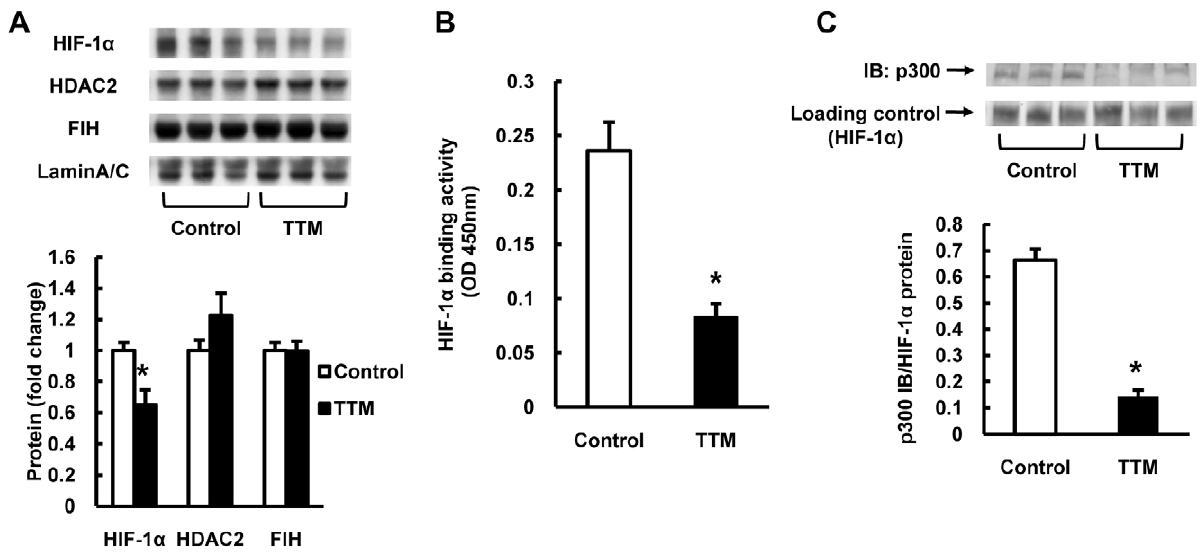
Figure 4. Copper depletion affects lung tissue HIF-1a protein expression and its transactivational activity. (A) Representative Western blot analysis of HIF-1 a , histone deacetylase 2 (HDAC2), p300, factor inhibiting HIF (FIH) and Lamin A/C in lung protein extracts from TTM treated rats. The bar graph shows the ratios of HIF-1 a , HDAC2, p300 and FIH protein expression relative to controls. (B) HIF-1 a activity was measured using a HIF- 1 a transcriptional factor assay kit and nuclear protein extracts from rat lungs. The activity was decreased in TTM treated rat lungs. (C) Representative photomicrograph of immunoprecipitation of HIF-1 a and p300, showing impaired HIF-1 a /p300 binding (IB:p300) in TTM treated rat lung nuclear protein extracts. The bar graph shows HIF-1 a /p300 binding protein expression relative to the loaded HIF-1 a protein. Data are expressed as mean 6 SE (n=6). *P , 0.05 versus control.